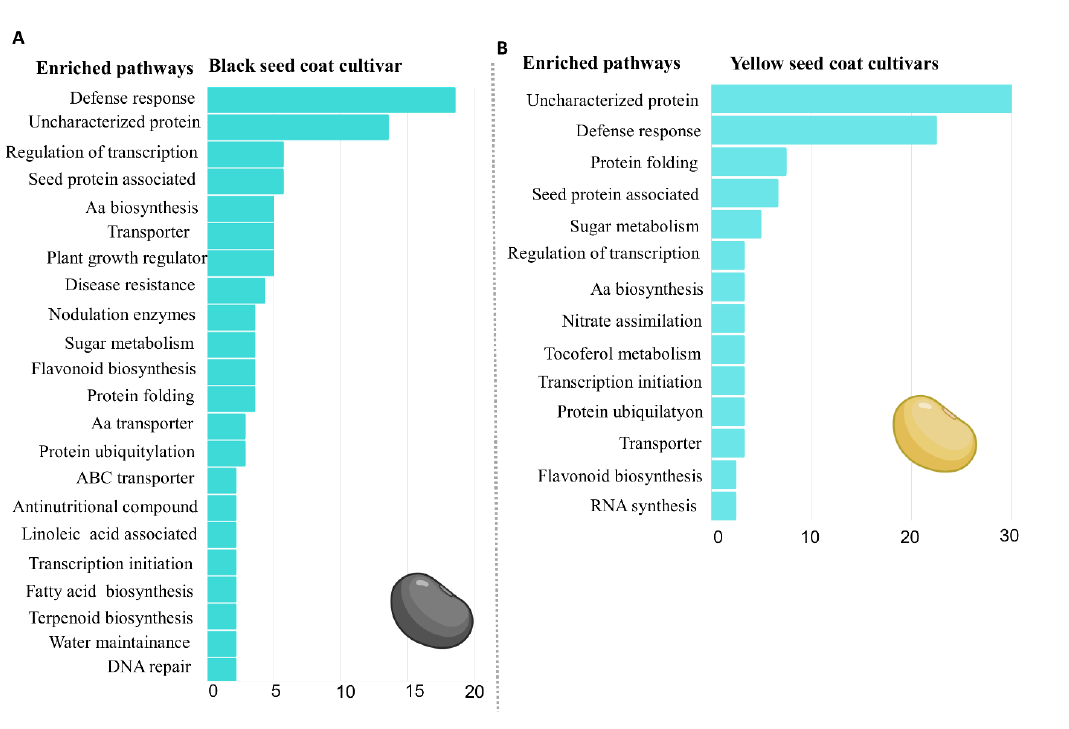
Figure 3. Metabolic pathways enriched in cultivar BRSMG 715A of soybeans in FHS and SCC ( A ) and in cultivars BRS 413 RR and DM 6563 IPRO in FHS and SCC ( B ). The black seed coat cultivar BRSMG 715A presented a total of 22 enriched routes in